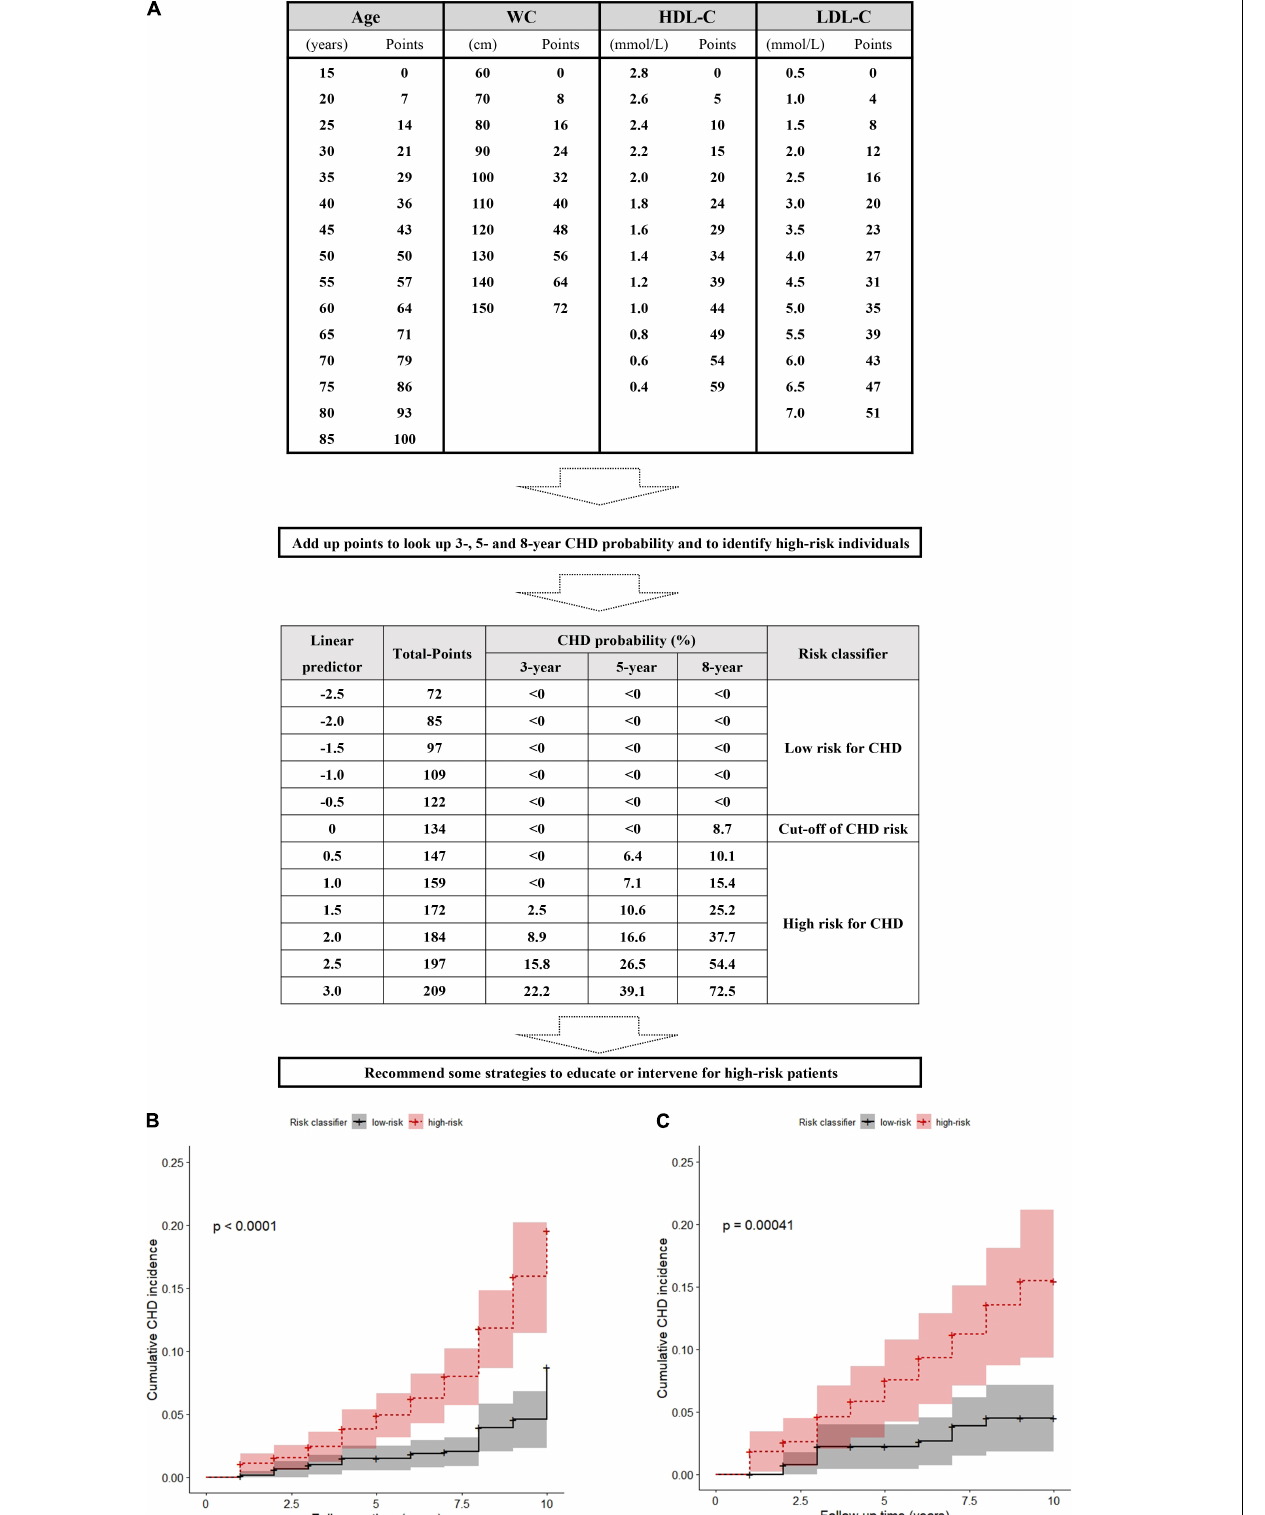
Frontiers in Cardiovascular Medicine |